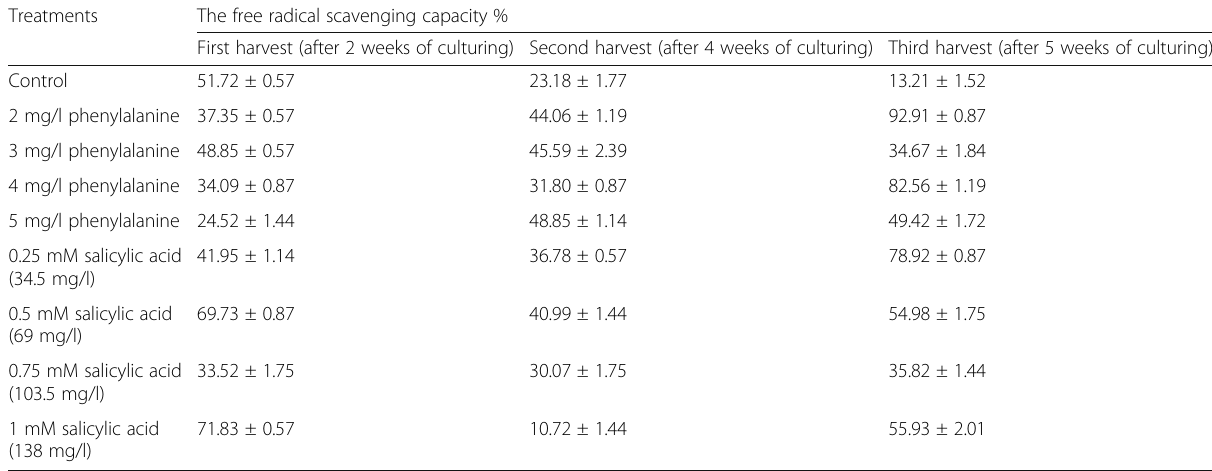
Table 3 The free radical scavenging capacity percentage in gardenia calli cultures cultured on MS media contained different concentrations of phenyl alanine or salicylic acid during the three harvested periods of culturing Treatments